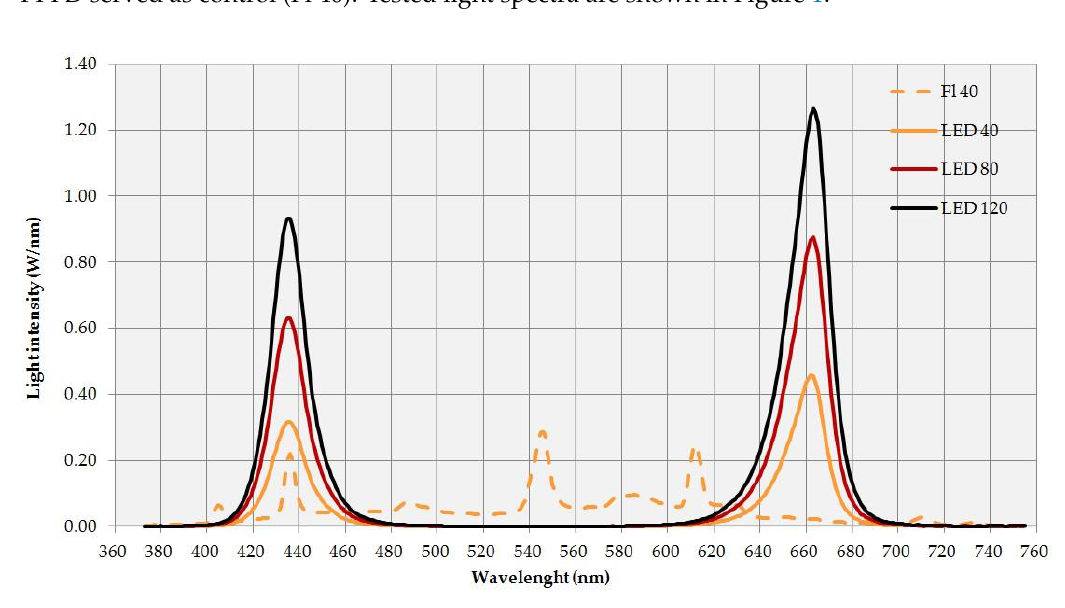
Figure 1. Tested light spectra during in vitro cultures of Gerbera jamesonii . Fl 40 — control, fluorescent Philips TK-D 36W/54 lamps. LED 40, LED 80, LED 120 — light-emitting diodes (red and blue 7:3) with photosynthetic photon flux densities (PPFDs) of 40, 80, or 120 µmol m −2 s −1 , respectively. LED — light-emitting diode.